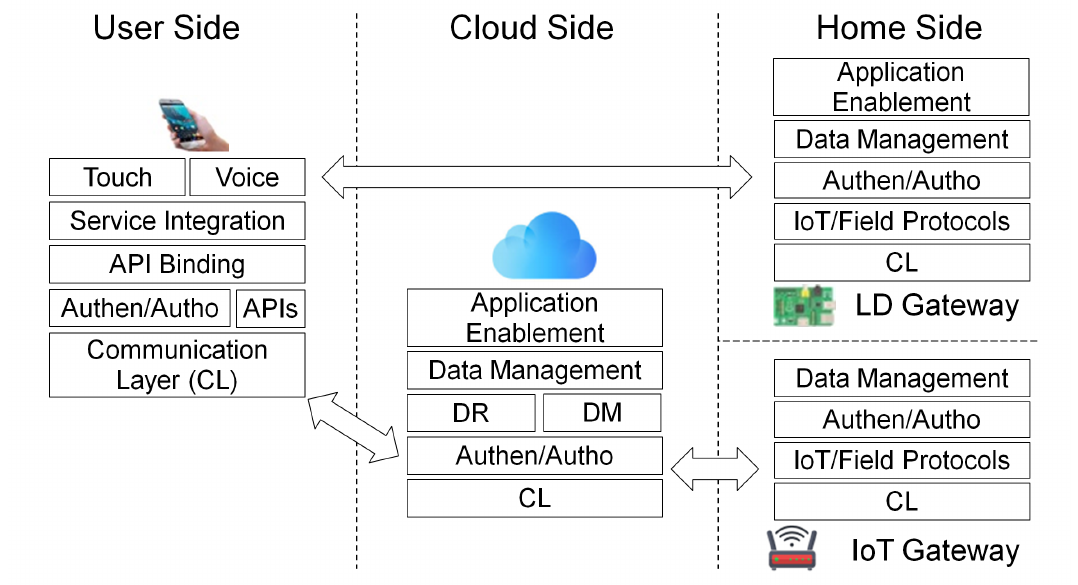
Figure 3. Interactions relevant for the smart home: user side ( left ), cloud side ( center ), and home side ( right ). Authen/Autho: authentication/authorization, DR: device registry, DM: device management, LD: legacy